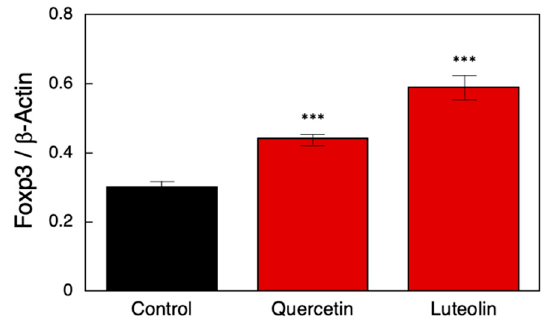
Figure 3. Quercetin and luteolin treatment affected FOXP3 mRNA expression in PBMCs. FOXP3 mRNA levels were determined via quantitative polymerase chain reaction in triplicate. Two-sided Student’s t -test was used to test for significant differences compared to results of the controls. Sig- nificance was defined as *** p < 0.001. FOXP3: forkhead box P3; PBMCs: peripheral blood mononu- clear cells.